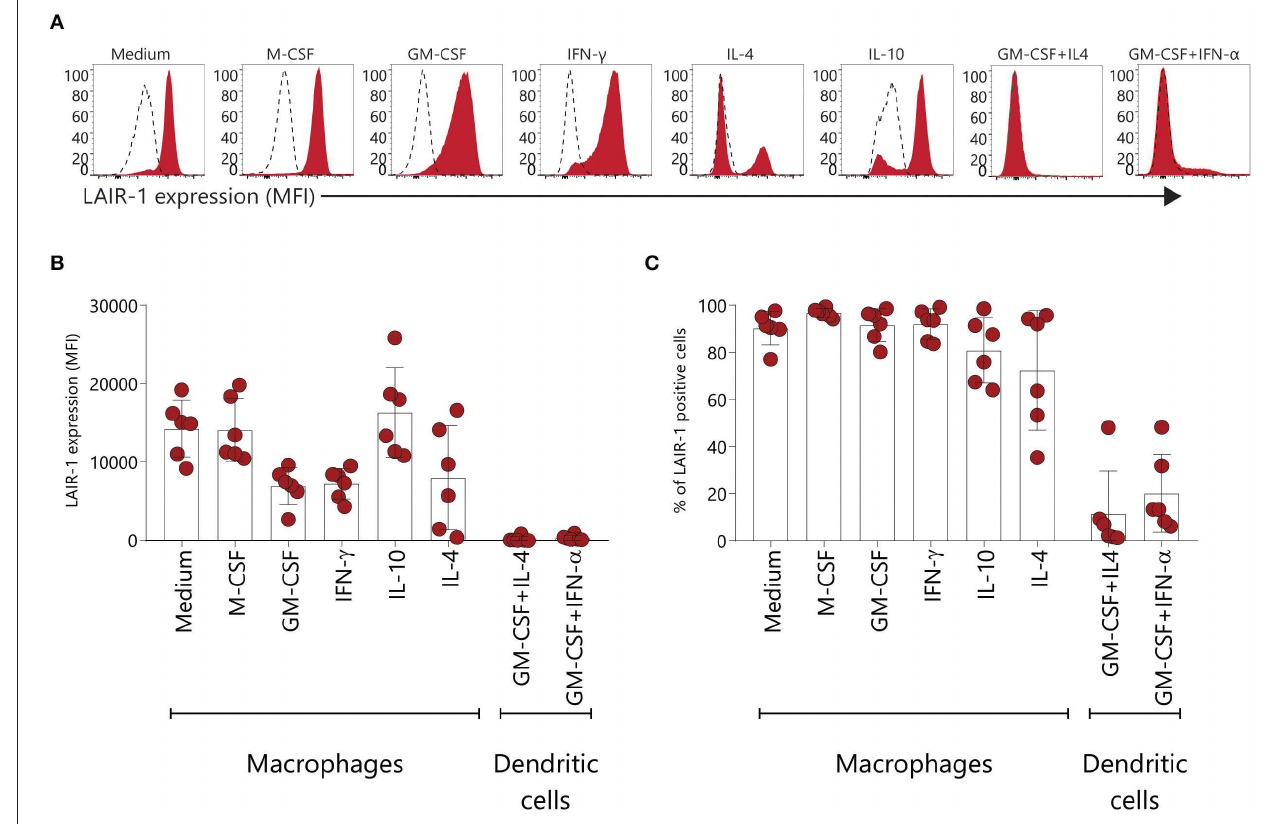
FIGURE 4 | LAIR-1 is downregulated on GM-CSF and IFN- γ monocyte-derived macrophages and monocyte derived-dendritic cells. (A) Representative histogram of LAIR-1 expression assessed on different types of in vitro monocyte-derived macrophages and dendritic cells using flow cytometry. (B) Quantification of LAIR-1 expression represented as median fluorescence intensity (MFI). (C) The percentage (%) of cells expressing LAIR-1 is displayed. Results are represented as mean with